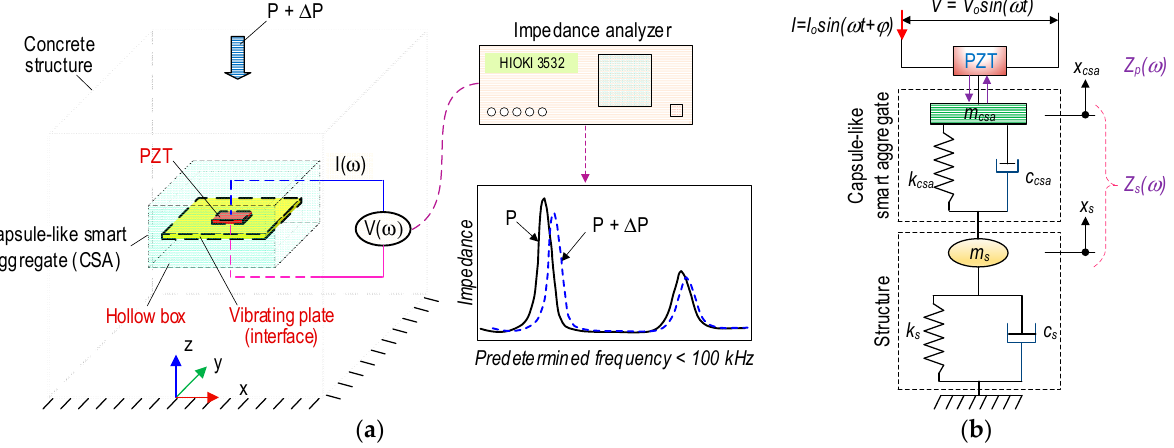
Figure 1. Conceptual model of CSA in concrete structure under compression. ( a ) CSA-embedded concrete structure. ( b ) 2-DOF impedance model.